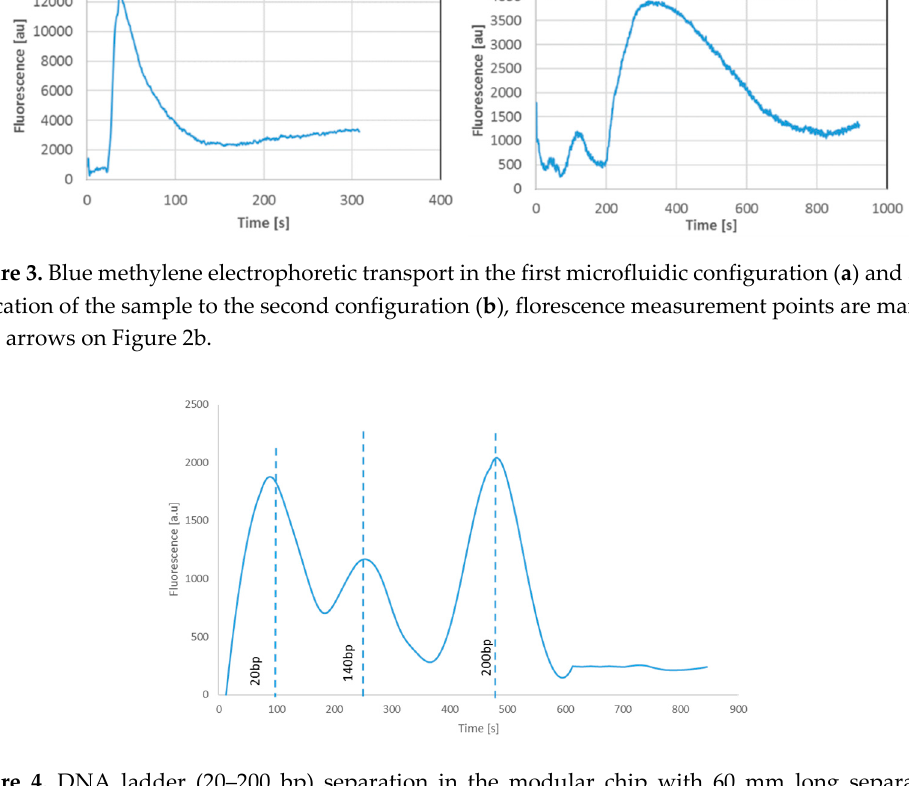
Figure 4. DNA ladder (20–200 bp) separation in the modular chip with 60 mm long separation microchannel and fluorescence